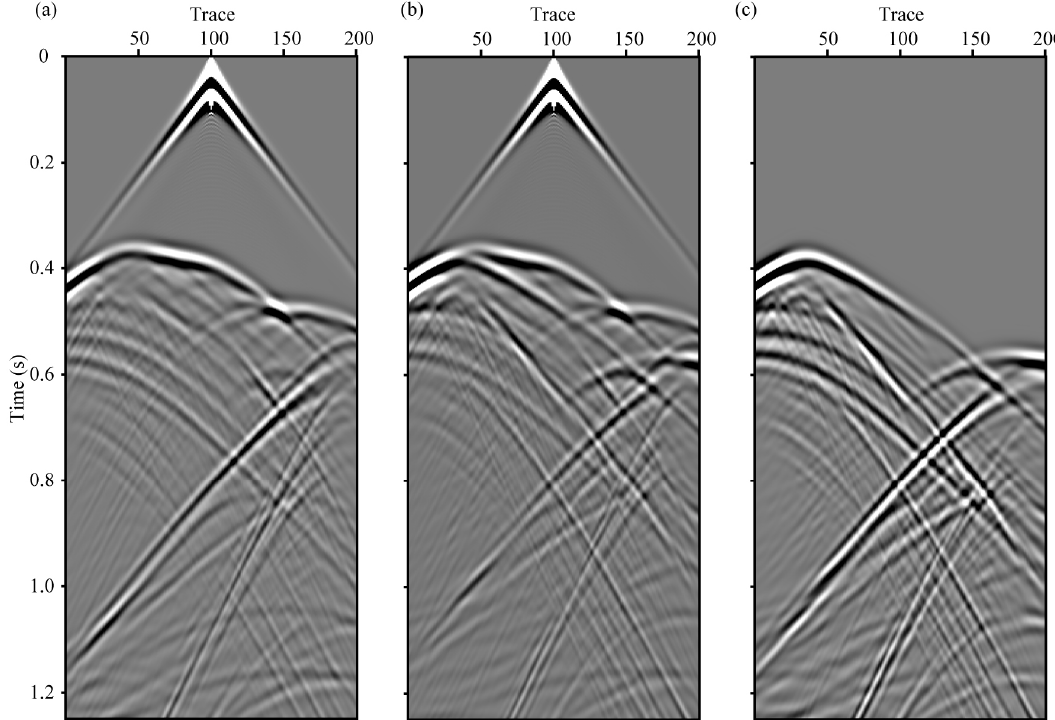
Figure 12. Comparison of Z-component waveforms in line 1 with and without the shale anisotropy (JY model). ( a ) is the Z-component wavefield of model M 0 (without anisotropy), ( b ) is the Z-component wavefield of model M ED (with anisotropy), and ( c ) is the residual wavefield for ( a ) and ( b ).